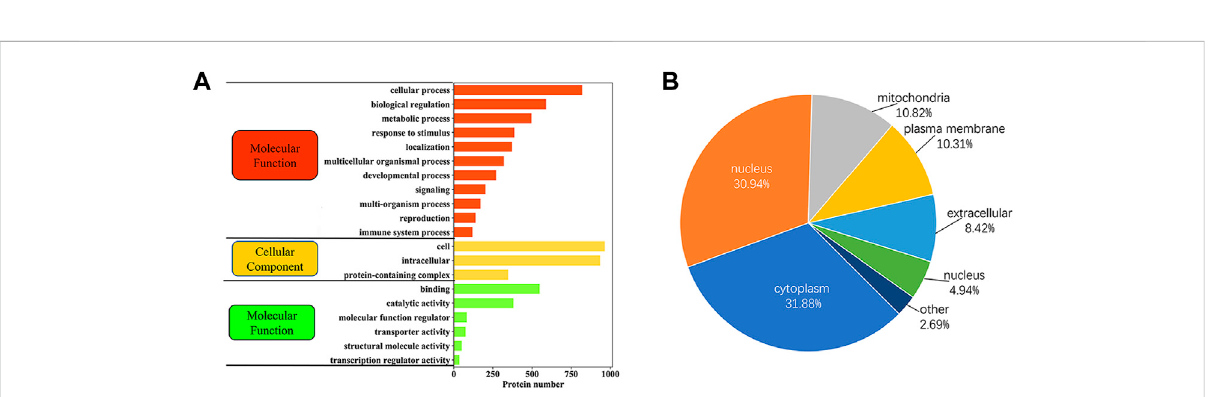
Thefunctionalclassi fi cationofphosphorylated proteinsinyak sperm. (A) GO functionalenrichmentofphosphorylated proteins. (B) Subcellular localization of phosphorylated